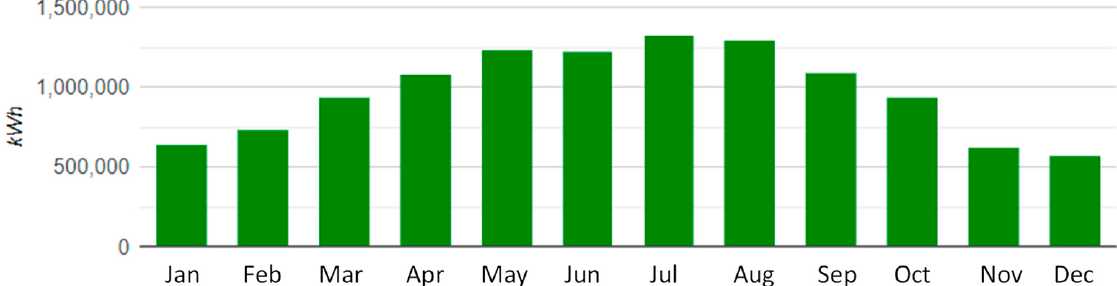
Figure 3. Yearly production for an 8 MW photovoltaic plant with 20,000 30 deg slanted panels of 400 W peak each. The calculus was performed for an installation in Lecce (southern Italy). Yearly PV production: 11,710,400 kWh.